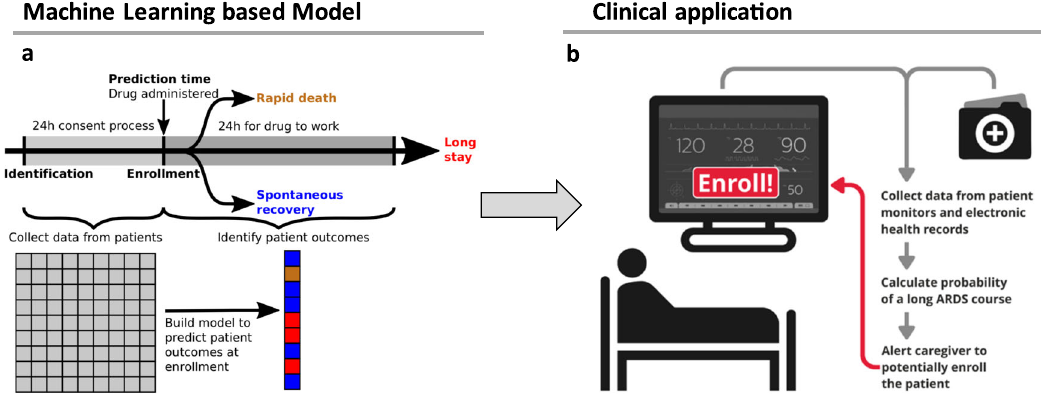
Fig. 1 Overview of proposed model use case. Schematic illustration model building and patient strati fi cation (a). Here, patients with a high probability of a long ARDS course will be predicted using data from both electronic health records and real-time patient monitoring. Caregivers can then be alerted when such a patient is identi fi ed (b).